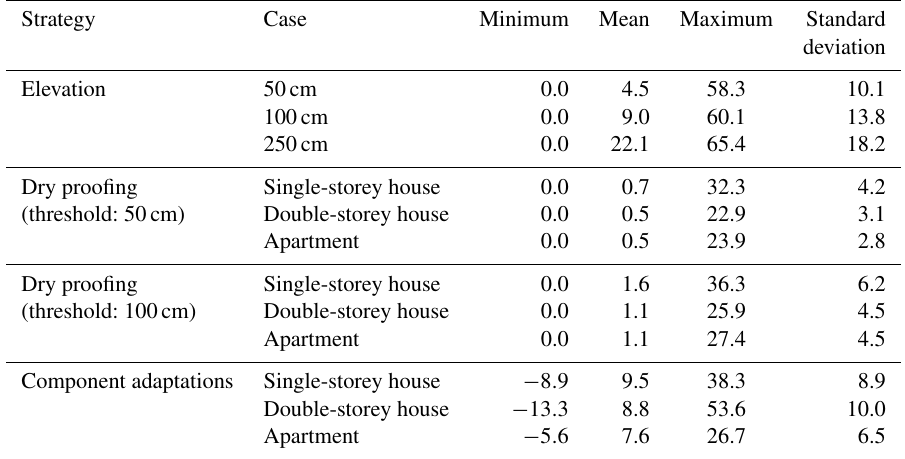
Table 8. Distribution of efficacy in thousands of euros across all numerical models of dwellings and all combinations of immersion depth and duration.